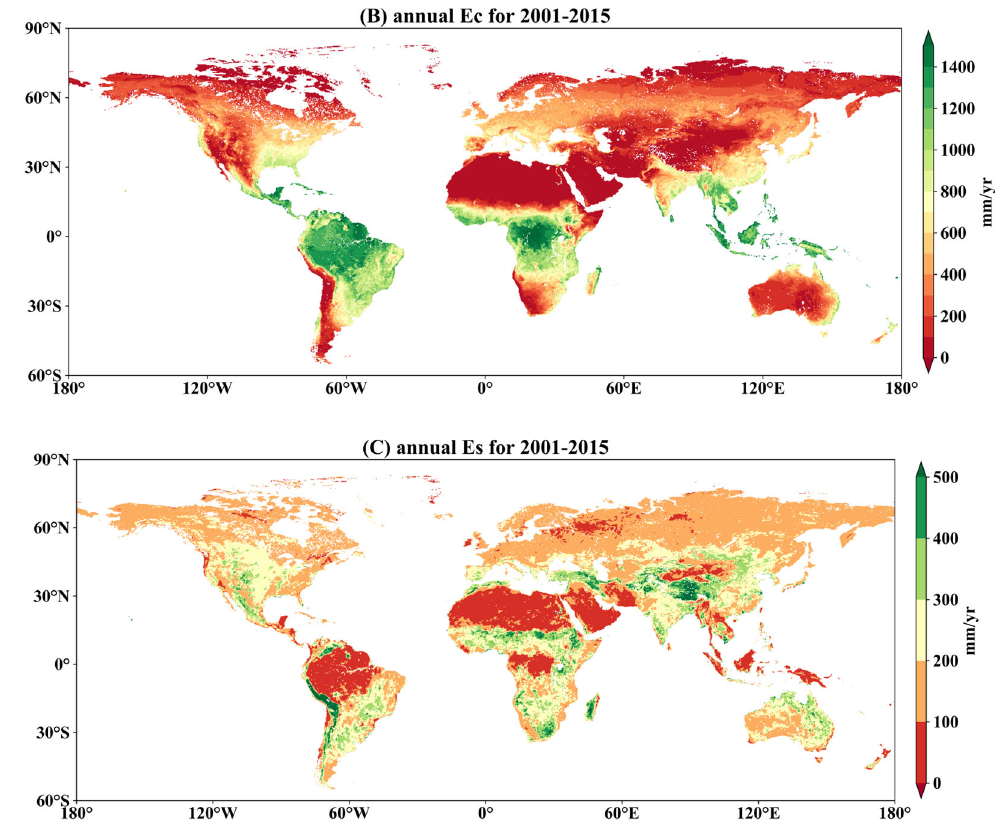
Figure 1. Spatial distribution map of multi–year annual ET ( A ), E c ( B ) and E s ( C ).